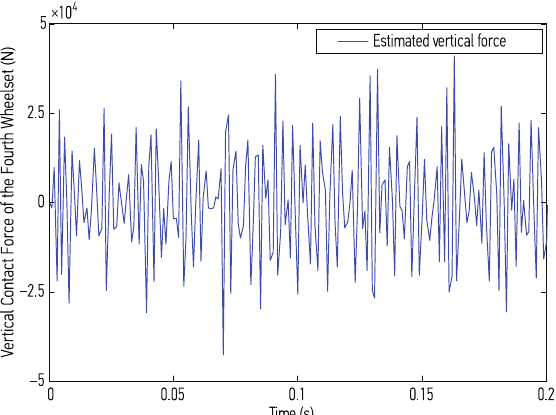
Fig. 2. Measured and inversed accelerations for the fourth axle box